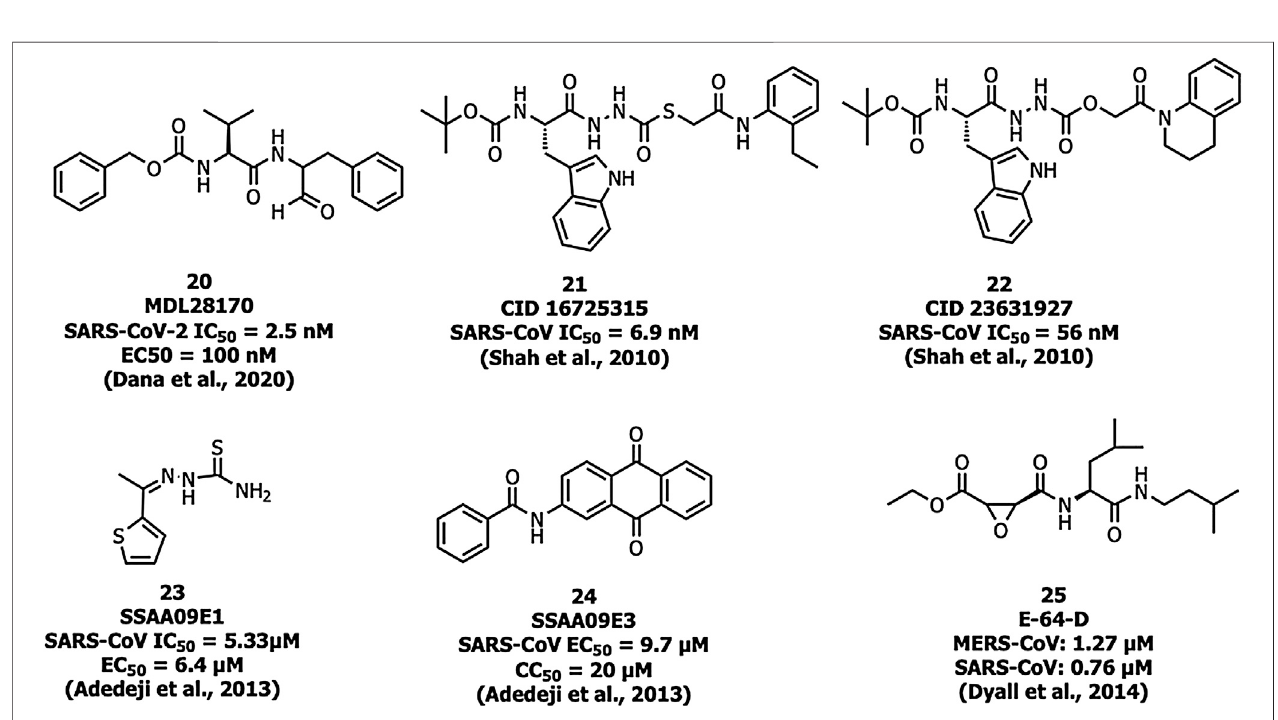
FIGURE 9 | Cathepsin L inhibitors with antiviral activity.